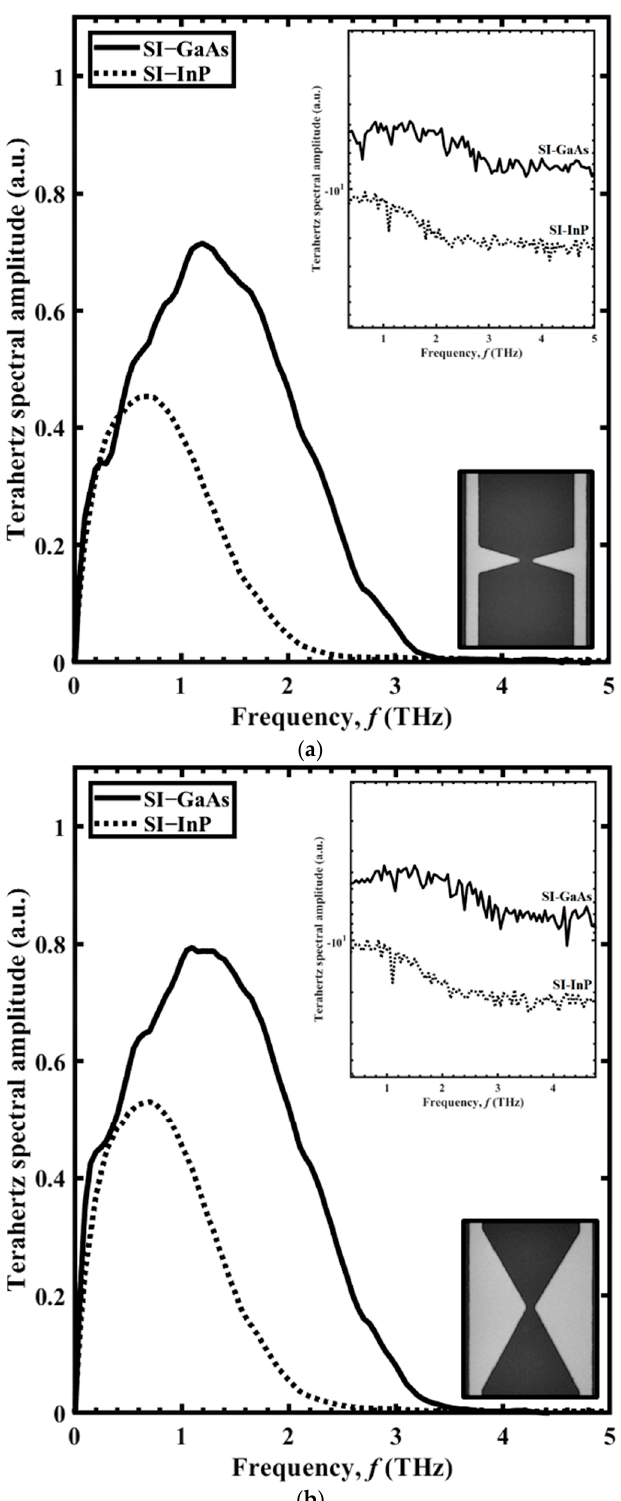
Figure 4. The THz spectral amplitude as a function of frequency, f, for PC THz emitters incorporating SI-GaAs (solid lines) and SI-InP (dotted lines) in the form of the ( a ) Sharp BT and ( b ) Broad BT. The THz spectral amplitudes are shown on a log scale in the upper insets, and the two structures are shown as SEM images in the lower insets, with lighter colour denoting metal. Results for the THz spectral amplitude as a function of frequency, f , are shown in Figure 5 for the bow-tie antennas with (a) Asymmetric BT, (b) Blunted BT, and (c) Doubled